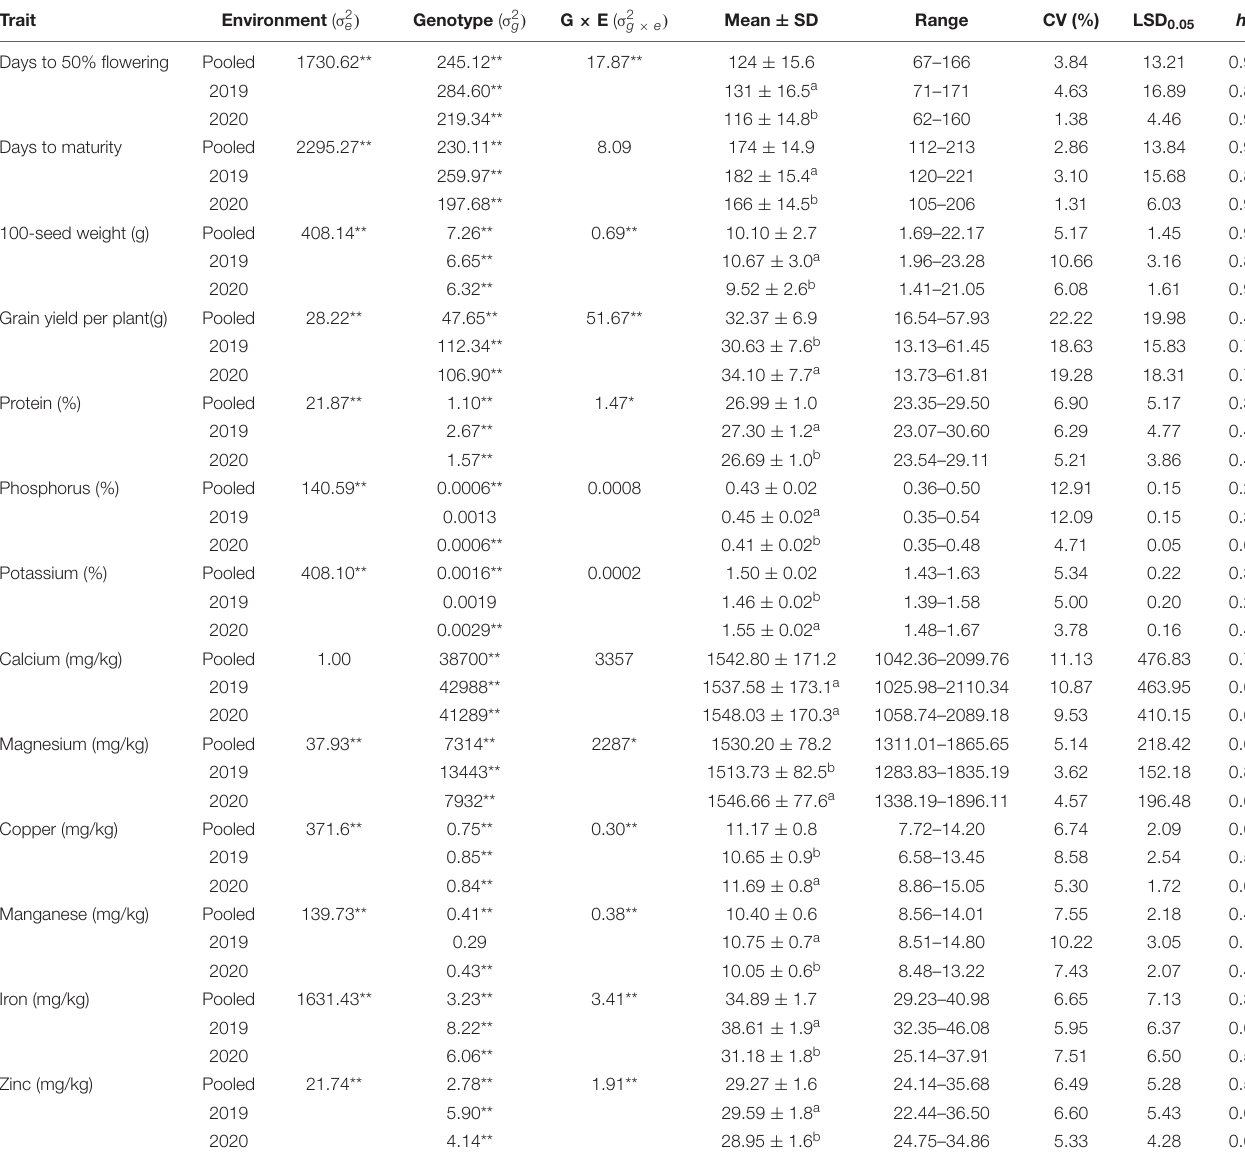
TABLE 1 | Variance, mean, range, co-efficient of variation (CV %), least significant difference (LSD 0 . 05 ), and heritability (broad sense) for agronomic and grain nutritional traits of pigeonpea accessions evaluated during 2019 and 2020 rainy seasons at ICRISAT, Hyderabad, India.